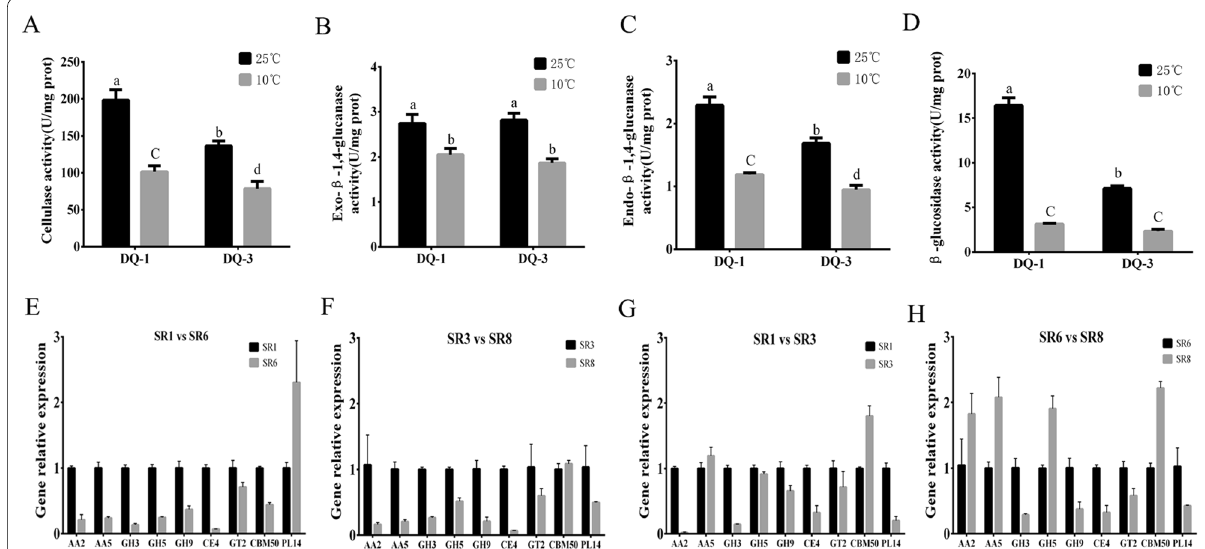
Fig. 5 Analysis of carbohydrate enzyme activity and gene expression level verification under the different temperature treatments . A – D Changes in cellulase, exo/endo-β-1,4-glucanase and β-glucosidase activity under the different treatments. E , F Validation of the expression levels of nine differentially expressed CAZymes (AA2, AA5, GH3, GH5, GH9, CE4, GT2, CBM50 and PL14). The error bars represent the means of triplicate